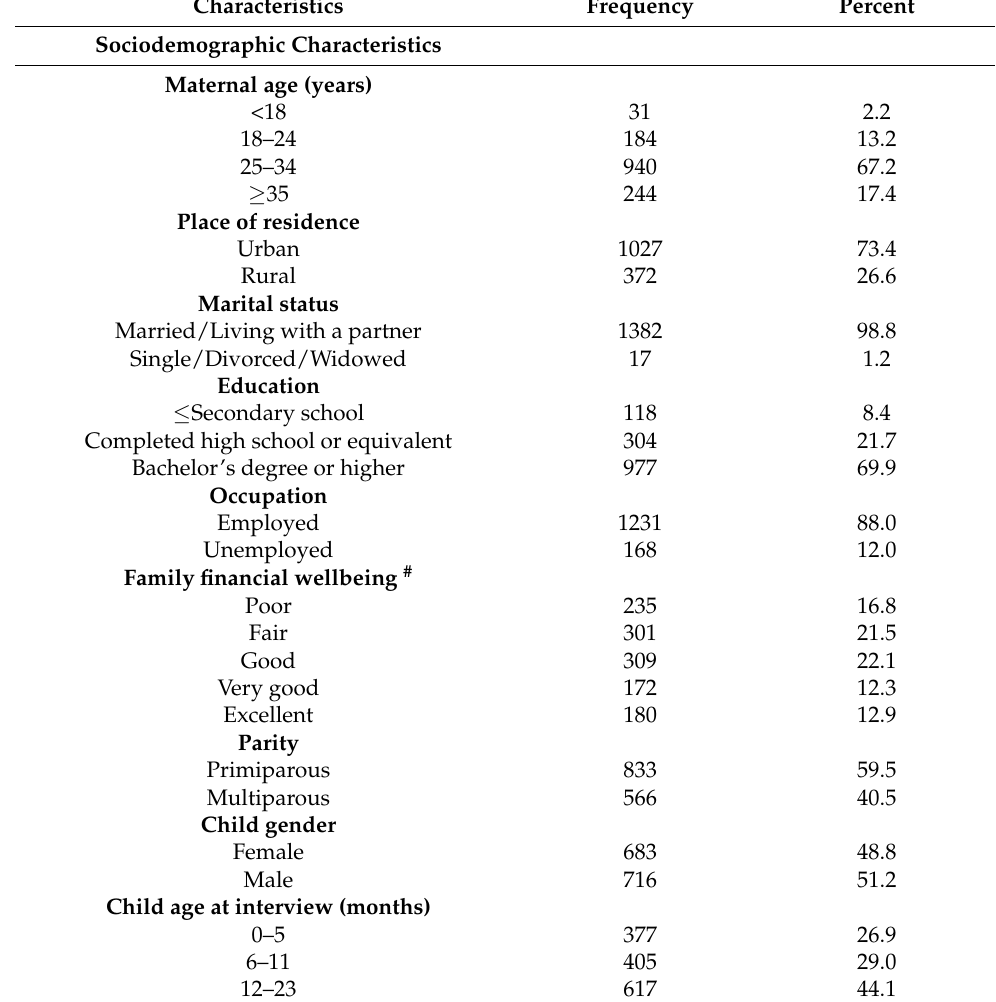
Table 1. Sociodemographic and pre/perinatal characteristics of the participants ( n = 1399). Characteristics